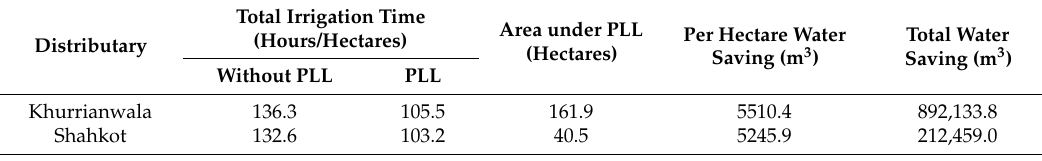
Table 4. Water savings from rice under PLL.